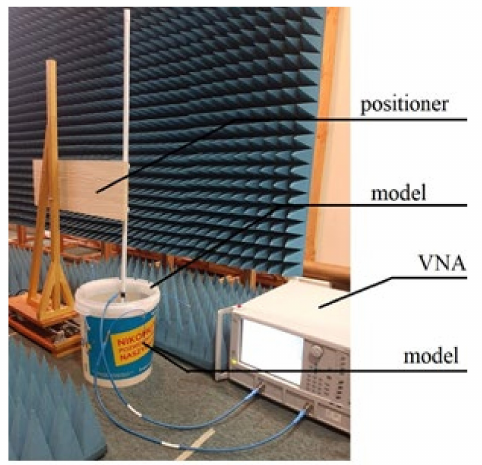
Figure 13. Measurement